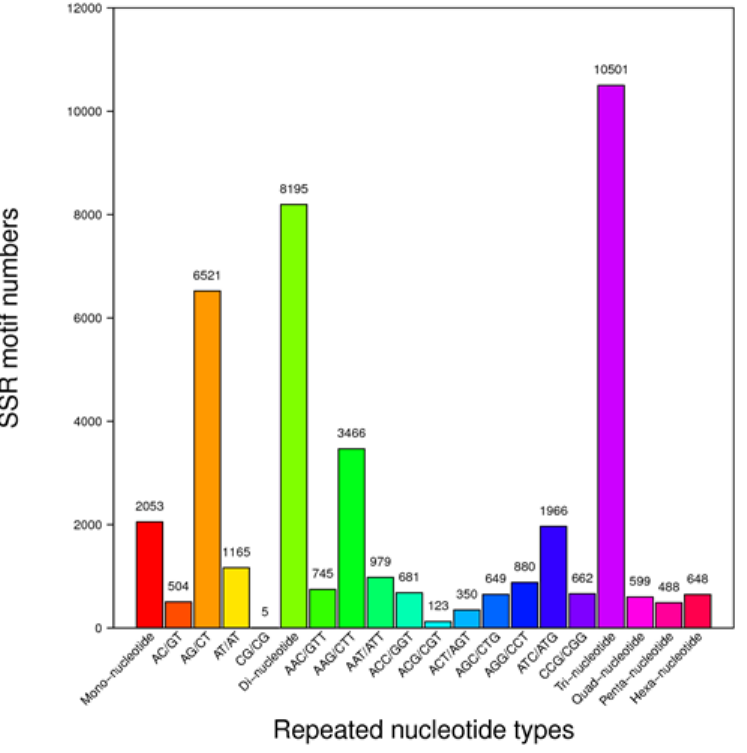
Figure 5. Distribution of simple sequence repeats (SSR) repeat types in impatiens unigenes.